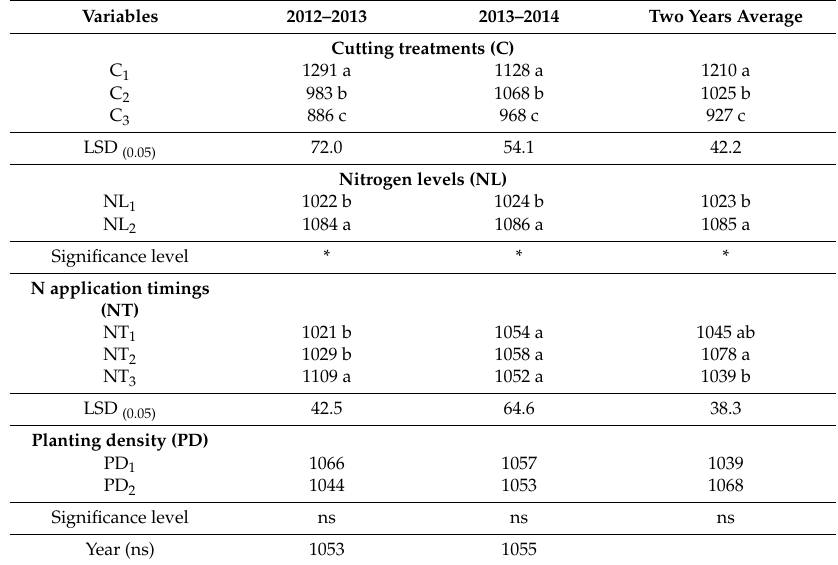
Table 4. Grain yield (kg ha − 1 ) of canola under cutting treatments, nitrogen levels and application timings under di ff erent planting